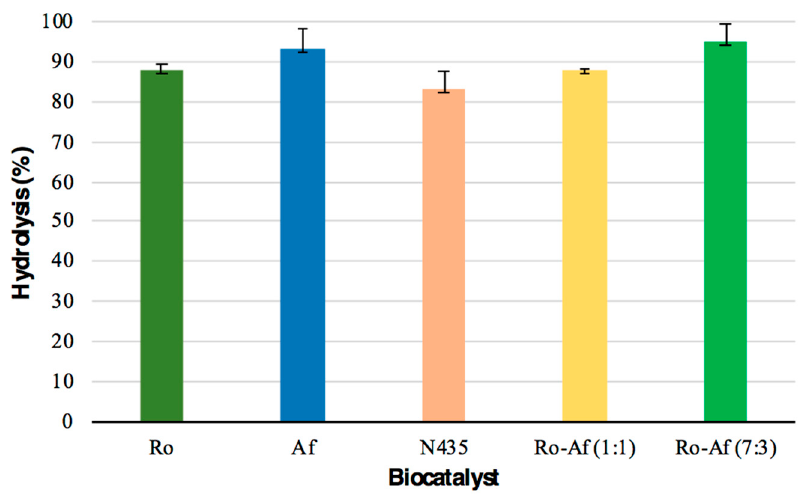
Figure 5. Hydrolysis percentage of monkfish liver oil obtained with the different enzymes (mean ± standard deviations, n = 3, reaction 24 h). Ro, R. oryzae ; Af, A. flavus ; N435, Novozym 435.